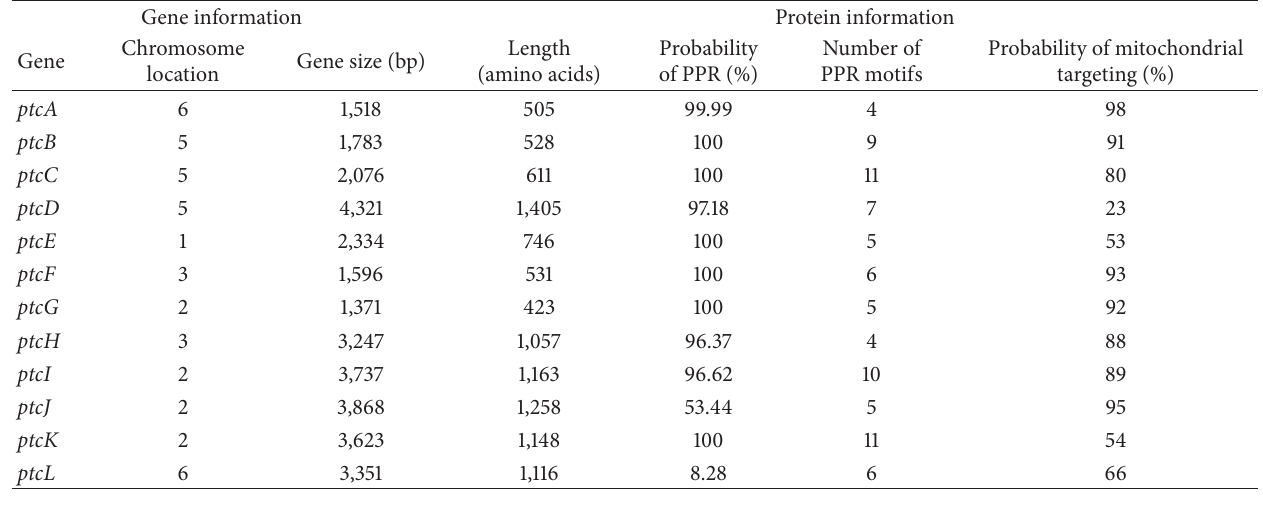
Table 1: Bioinformatic analysis of putative D. discoideum pentatricopeptide repeat candidates. The probability of the helical repeats being pentatricopeptide repeats and the number of motifs were predicted using TPRpred, and the probability of mitochondrial targeting was predicted using Mitoprot.